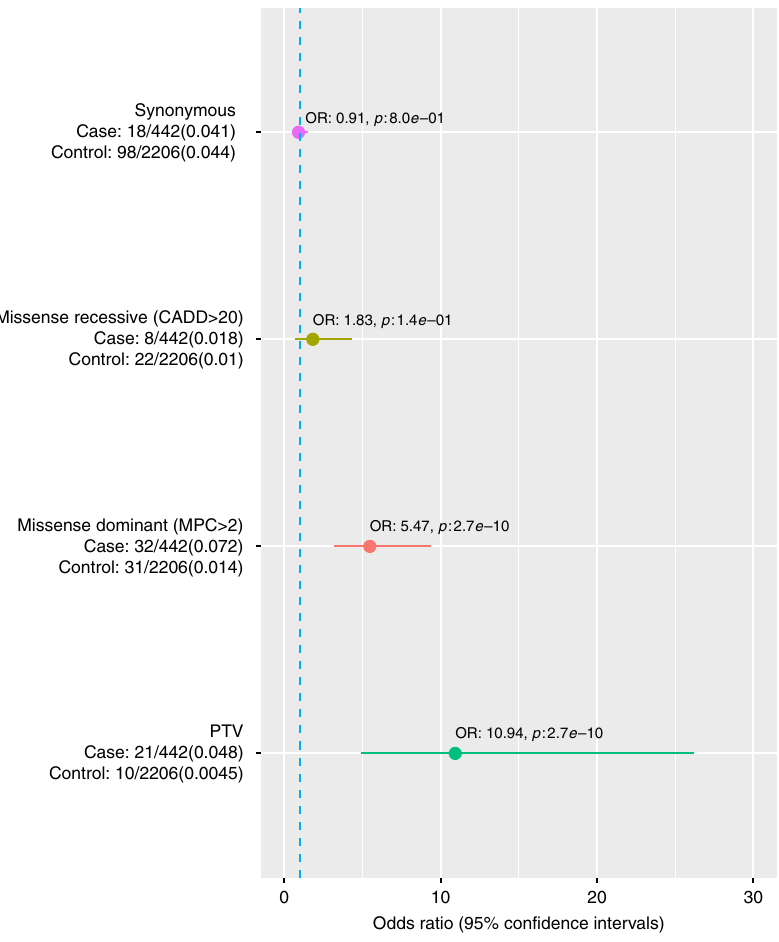
Fig. 2 Enrichment of likely pathogenic and synonymous variants in known ID genes. Enrichment of variants in 818 known ID genes (Methods) in NFID cases compared to genetically matched controls. Heterozygotes were counted only for those genes for which a dominant inheritance mode is reported. The number of carriers and total individuals are given on the left and in parenthesis the proportion of carriers. Circles indicate the odds ratio (OR) and lines indicate 95% con fi dence interval of the OR. The synonymous variant identi fi cation comparison was performed to assess if possible differences in the variant identi fi cation rate due to batch/capture differences were adequately controlled. PTV protein truncating variant, CADD Combined Annotation- Dependent Depletion pathogenicity score, pLI probability of loss of function intolerance. Source data are provided as a Source Data fi